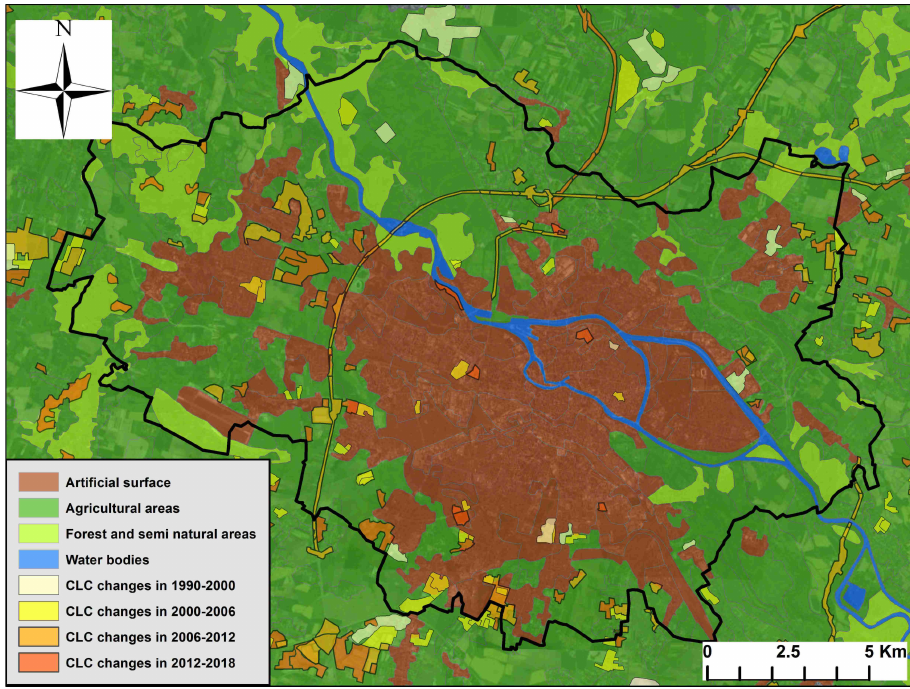
Figure 12. Corine Land Cover (CLC) and land cover change in 2000–2018 on the Wrocław